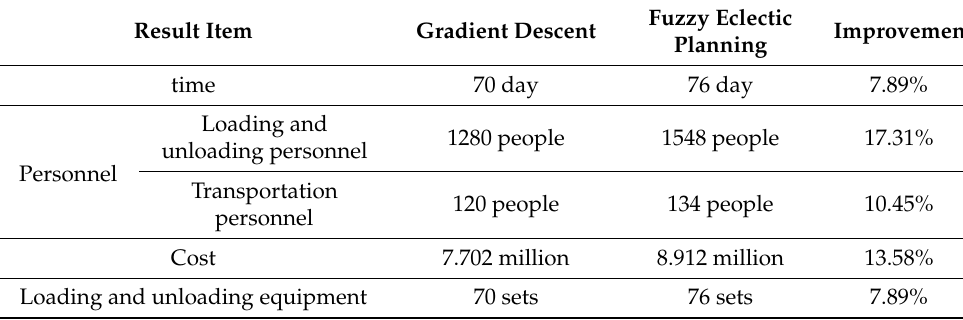
Table 2. Result of the transportation plan from different models.